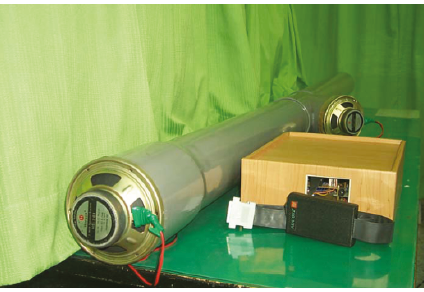
Figure 4: ANC laboratory workstation, which shows the self- developed DSP platform with JTAG emulator, a duct, and two loudspeakers.